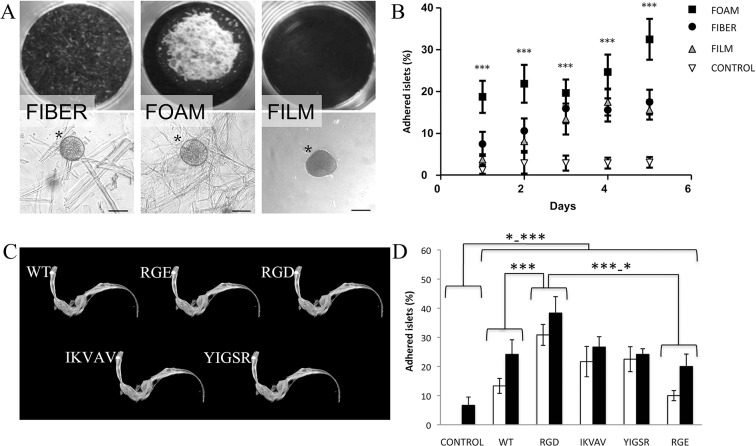
Mouse pancreatic islets adhere to silk matrices, with a preference for foam with RGD.
(A) Photographs of the various formats; fiber (left), foam (middle) and film (right) and micrographs together with adhered islet (lower panel, asterisks). Scale bars = 50μm. (B) Islet adherence after different time points (days). Islets adhered better to foam, fiber and film, compared to the control (n = 16, in duplicates, ***p<0.001). (C) Schematic descriptions of the spider silk proteins used; wild type 4repCT (WT) and 4repCT with different cell binding motifs (RGD, IKVAV and YIGSR) incorporated N-terminus of 4repCT. The non-functional peptide RGE was incorporated as control for RGD. (D) Islet adherence at day 1–2 (white bars) and day 5 (black bars) on foam with different motifs (n = 6, in duplicates). Islets adhered better to all silks compared to control (*** p≤0.001 at day 2, * p≤0.05 for WT and RGE at day 5, and **p≤0.001 for RGD, IKVAV and YIGSR at day 5). Islets adhered better to RGD compared to WT (*** p≤0.001 for day 2 and day 5) and RGE (*** p≤0.001 for day 2 and *p≤0.05 for day 5).